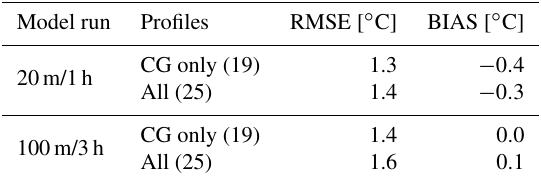
Table 6. Performance metrics of the modeled firn temperatures. For each case the number of considered profiles is reported in parenthe- ses (also see Sect. 2.2). All metrics are computed as the arithmetic mean of the respective depth-averaged values of each profile. For a uniform comparison across different profiles, both measured and modeled values were linearly interpolated to a 1cm vertical resolu- tion before computing